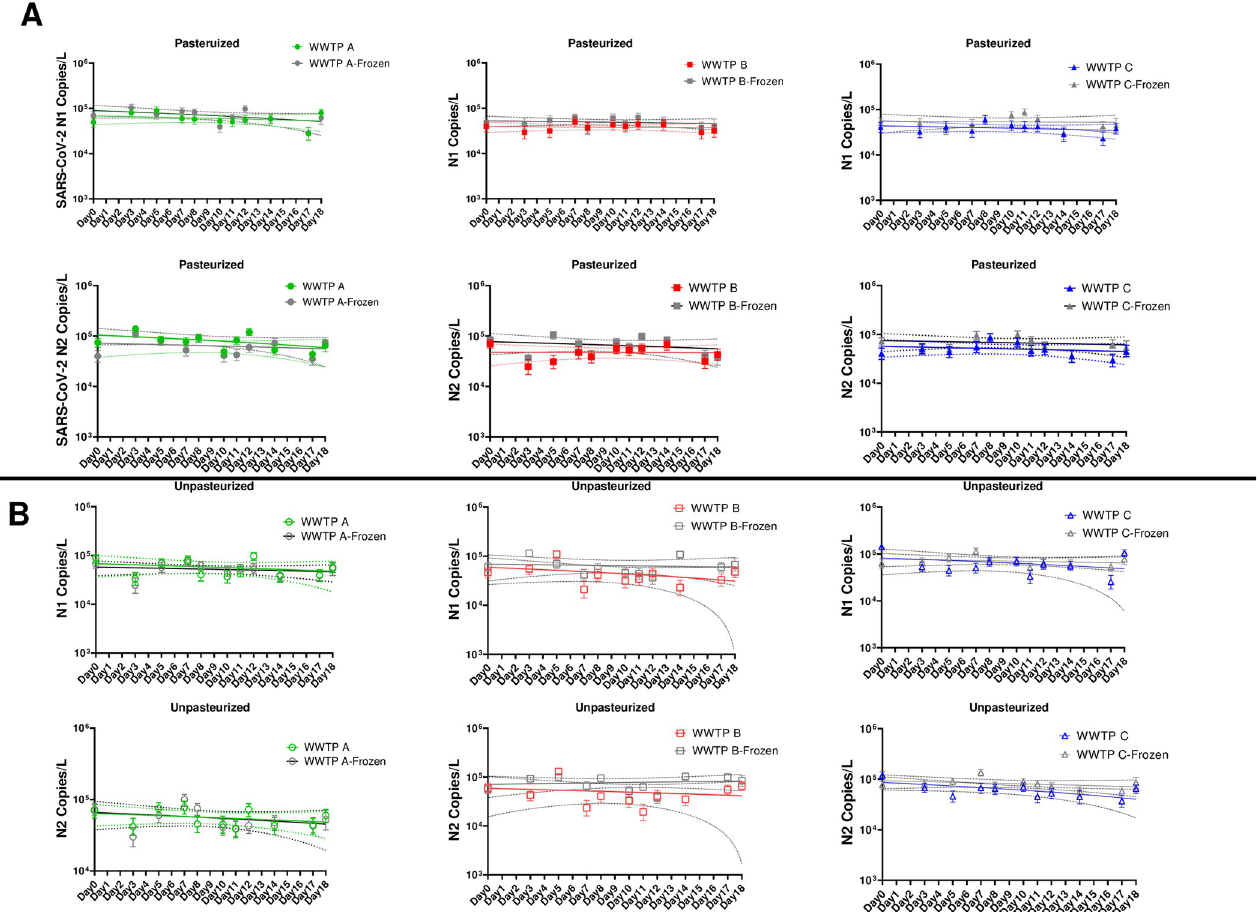
Fig 3. Concentration (copies/L) of SARS-CoV-2 N1 and N2 in heat pasteurized (A) and unpasteurized (B) samples at three WWTPs from filters frozen at -80˚C compared to never frozen filters. Samples are represented by the mean concentration of a minimum of 20,000 droplets per sample +/- the upper and lower 95% confidence interval. Linear regressions of copies/L over the 18-day experiment are represented by solid lines with the 95% confidence interval of the slope represented as dashed lines. A subset of samples was used for this comparison to ensure the same analyst who performed the analysis on never frozen filters also performed the analysis on their frozen filter